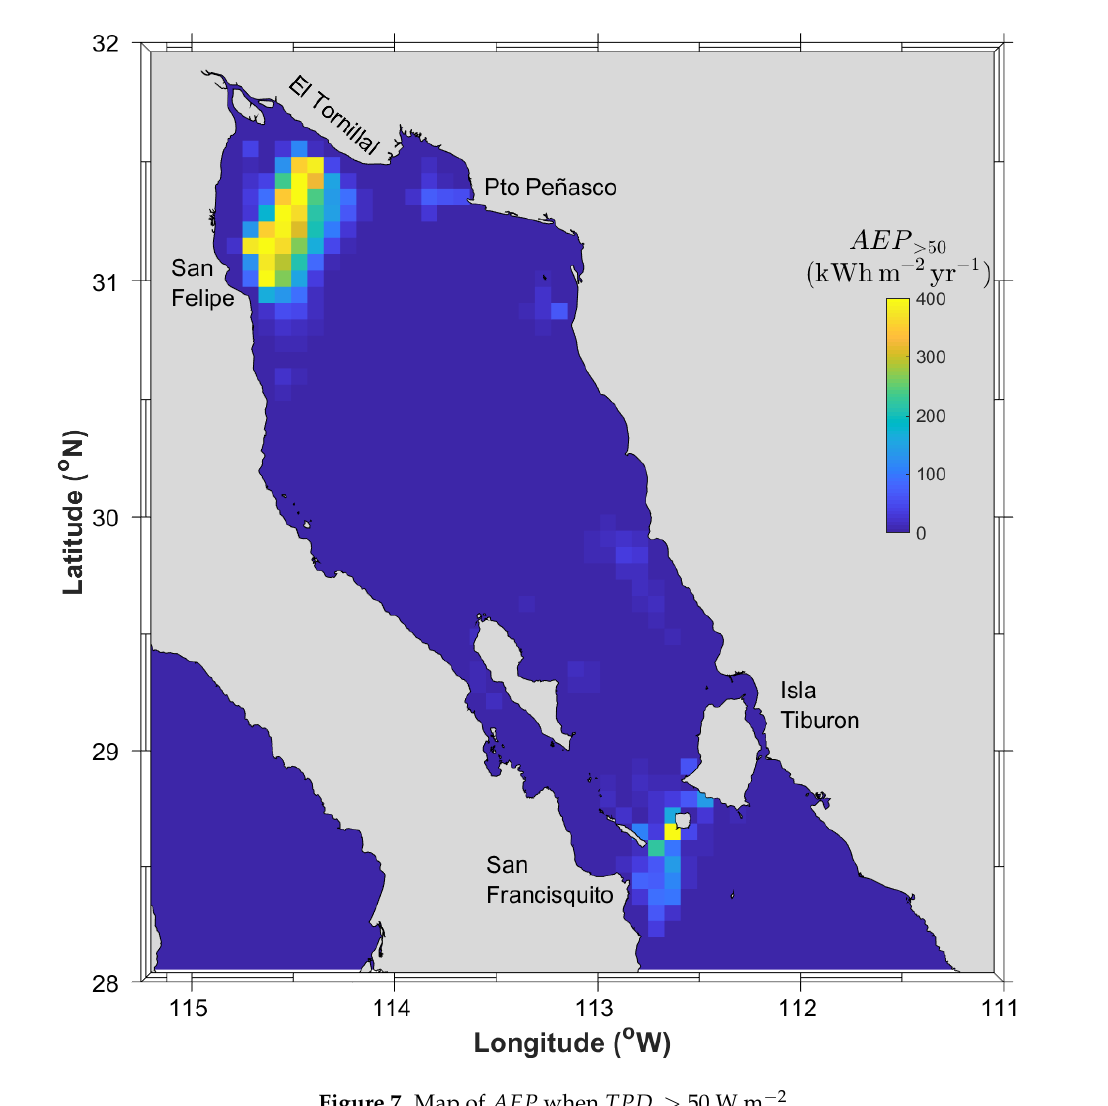
Figure 7. Map of AEP when TPD > 50 W m − 2